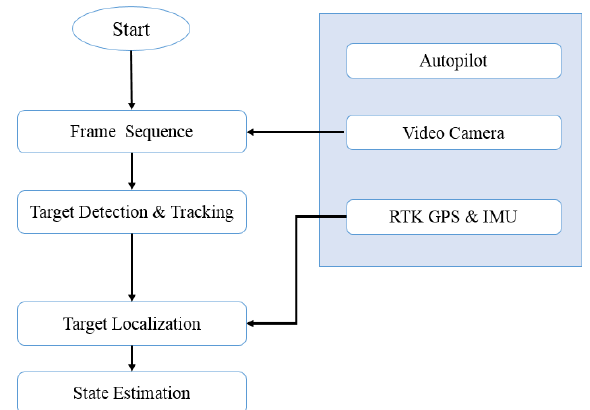
Figure 1: Flowchart of the proposed framework